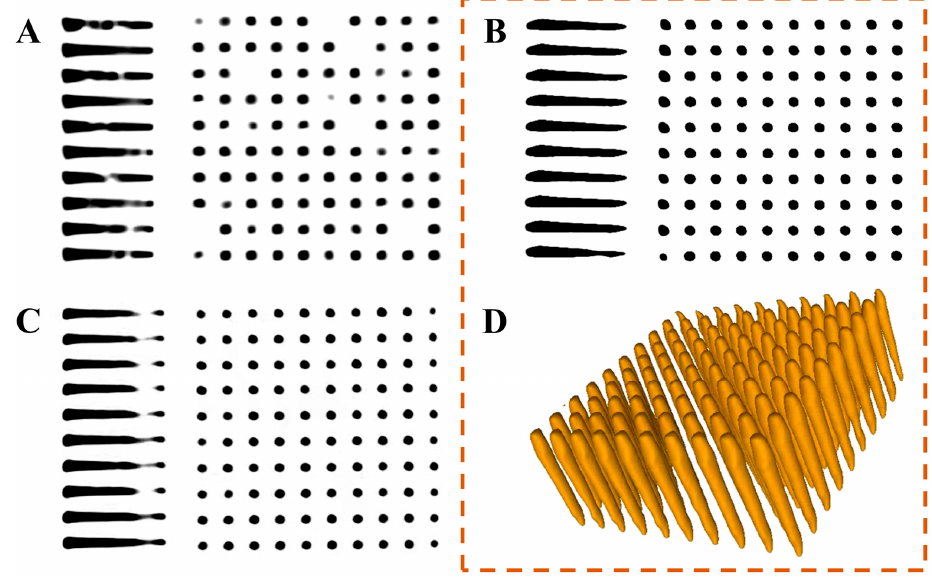
Figure 5. ( A – C ) 2D ‐ CT scans of the TDV after complete Cu filling at current densities of 0.15, 0.3, and 0.6 ASD, respectively. ( D ) 3D ‐ CT scan structure of ( B ).